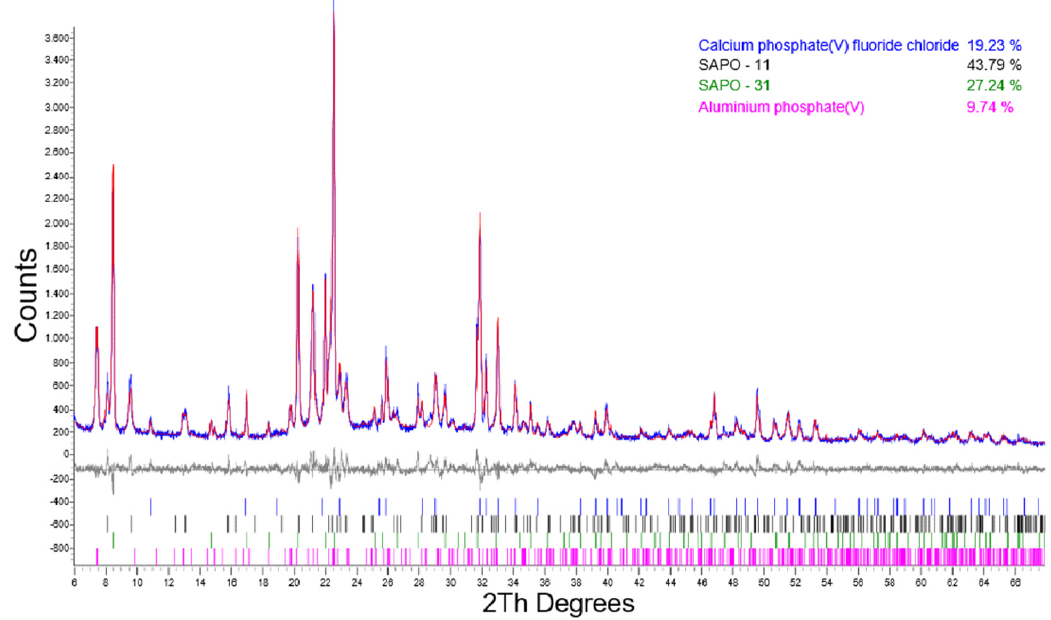
Figure A4. Rietveld refinement plot for 48/SHR0.5: the vertical lines provide the positions of all possible Bragg reflections for the aluminum phosphate (V) phases (database_code-ICSD 88566), calcium phosphate (V) fluoride chloride (database_code-ICSD 203026), structure of zeolite type AEL (database_IZA), and end structure of zeolite type ATO (database_IZA). The values of the standard agreement indices are Rp—7.86, Rwp—10.04, Rexp—6.23, GofF—1.61.